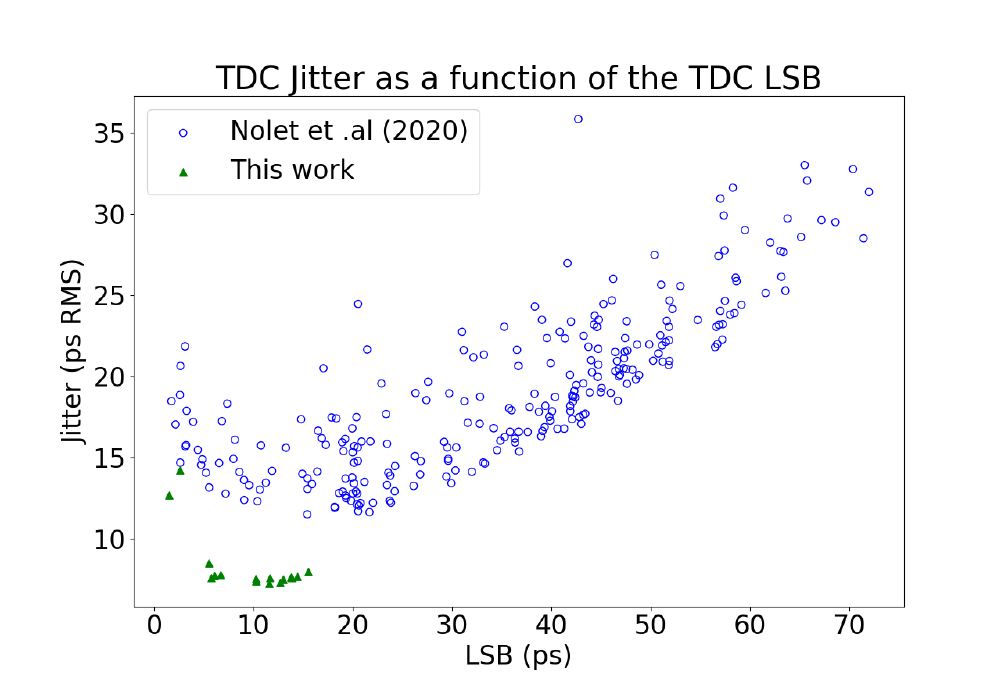
Figure 17. Jitter as a function of the LSB. The values from Figure 15 are compared to the results from Nolet (2020) [19] and illustrate the decreased variation of performance between TDCs. For example, in Nolet (2020), the LSB of every TDC would vary from 2 to 72 ps. In this work, this variation is from 2 to 16